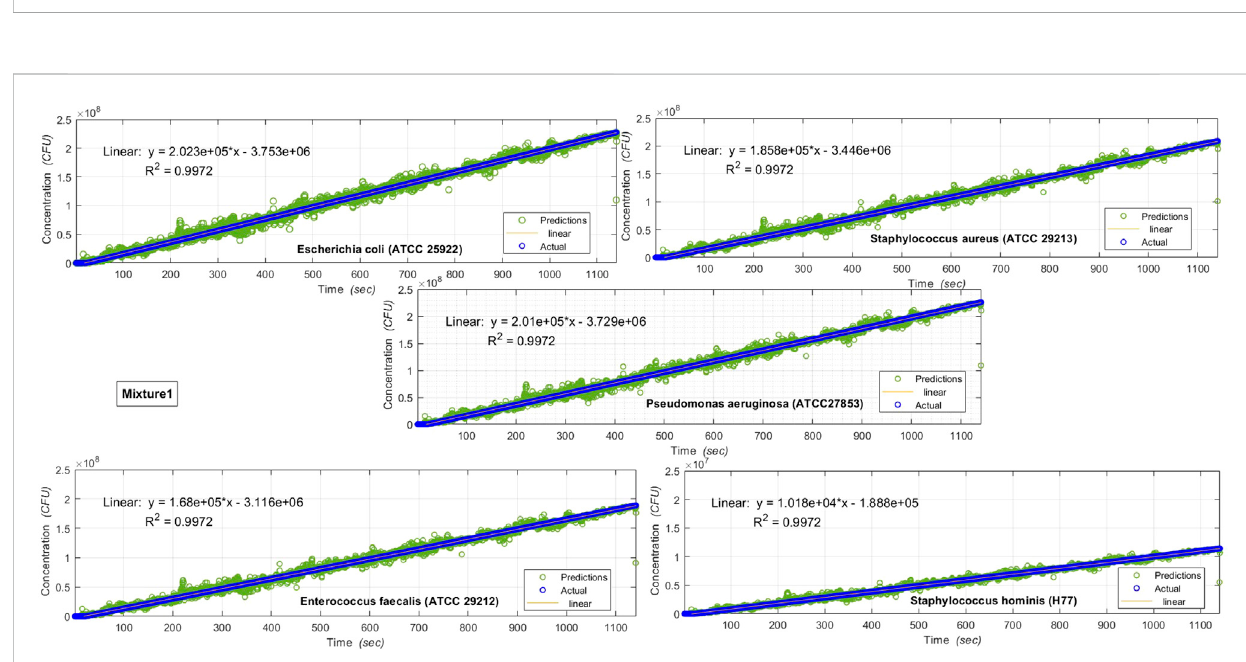
Results of various microbe characteristics determined by applying the Multi Variate Random Forest algorithm, on AUM ’ s backscatter observations during 20 min trial run, when Mixture 1 (comprising of fi ve different bacterial species with varying concentrations) was injected into the observation chamber. Results indicate good resolvability with high sensitivity and speci fi city. The time axis shows the scattering artifacts of no bioaerosols (with sample injection starting at 10 sec after the start of trial) and of bioaerosols injection (from 10 sec to 1,140 sec